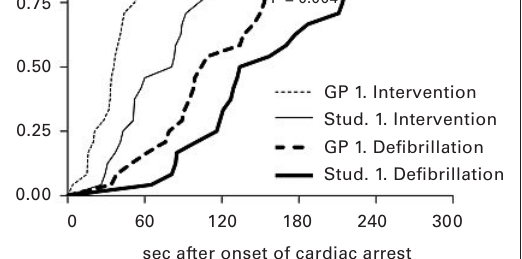
Behavioural ratings during cardiopulmo- nary resuscitation in simulated cardiac